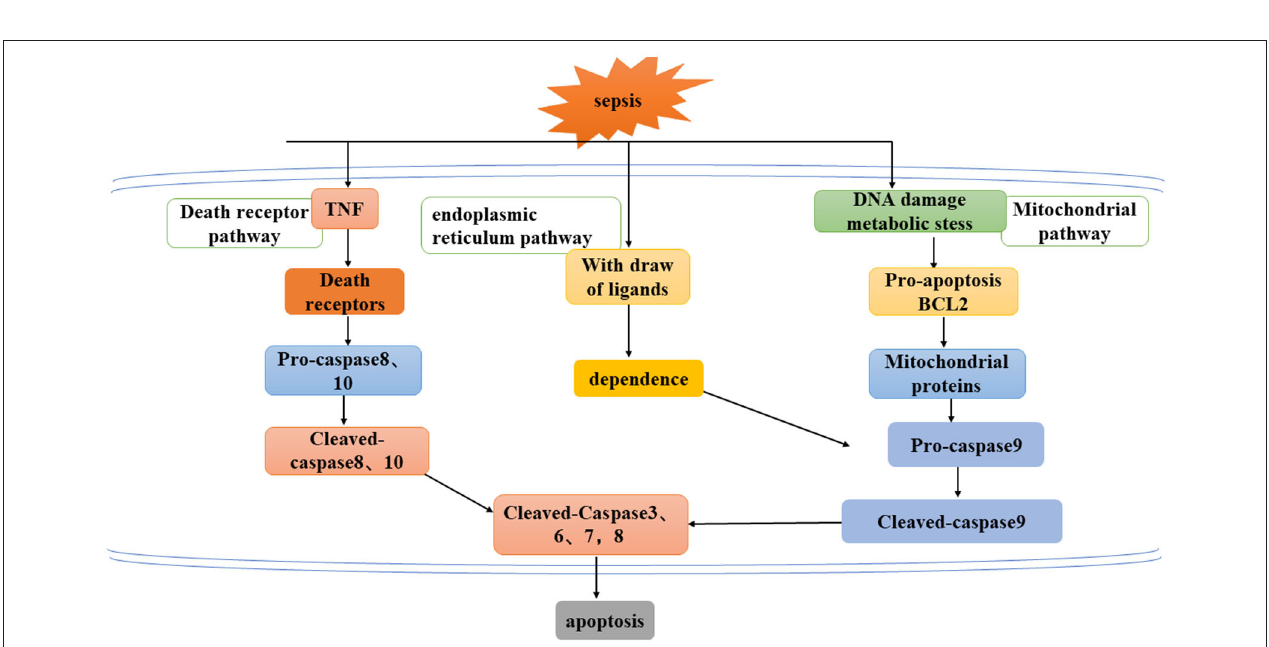
FIGURE 2 | Three ways to mediate apoptosis: exogenous pathway mediated by death receptor, endogenous pathway mediated by mitochondria, and endoplasmic reticulum pathway.